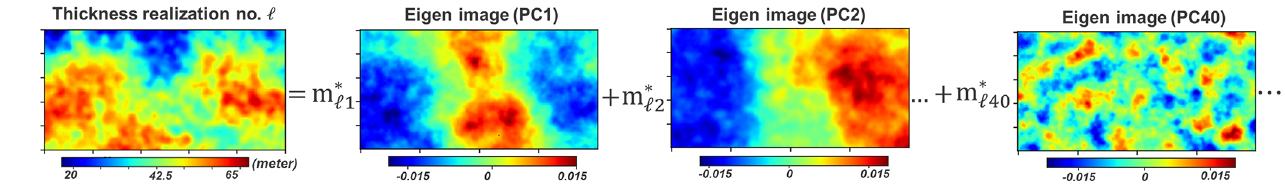
Figure 9. Example of applying PCA to thickness model. One model realization l ( l = 12 ,...L ) can be represented by the linear combination of eigen images scaled by the PC scores m ∗ l